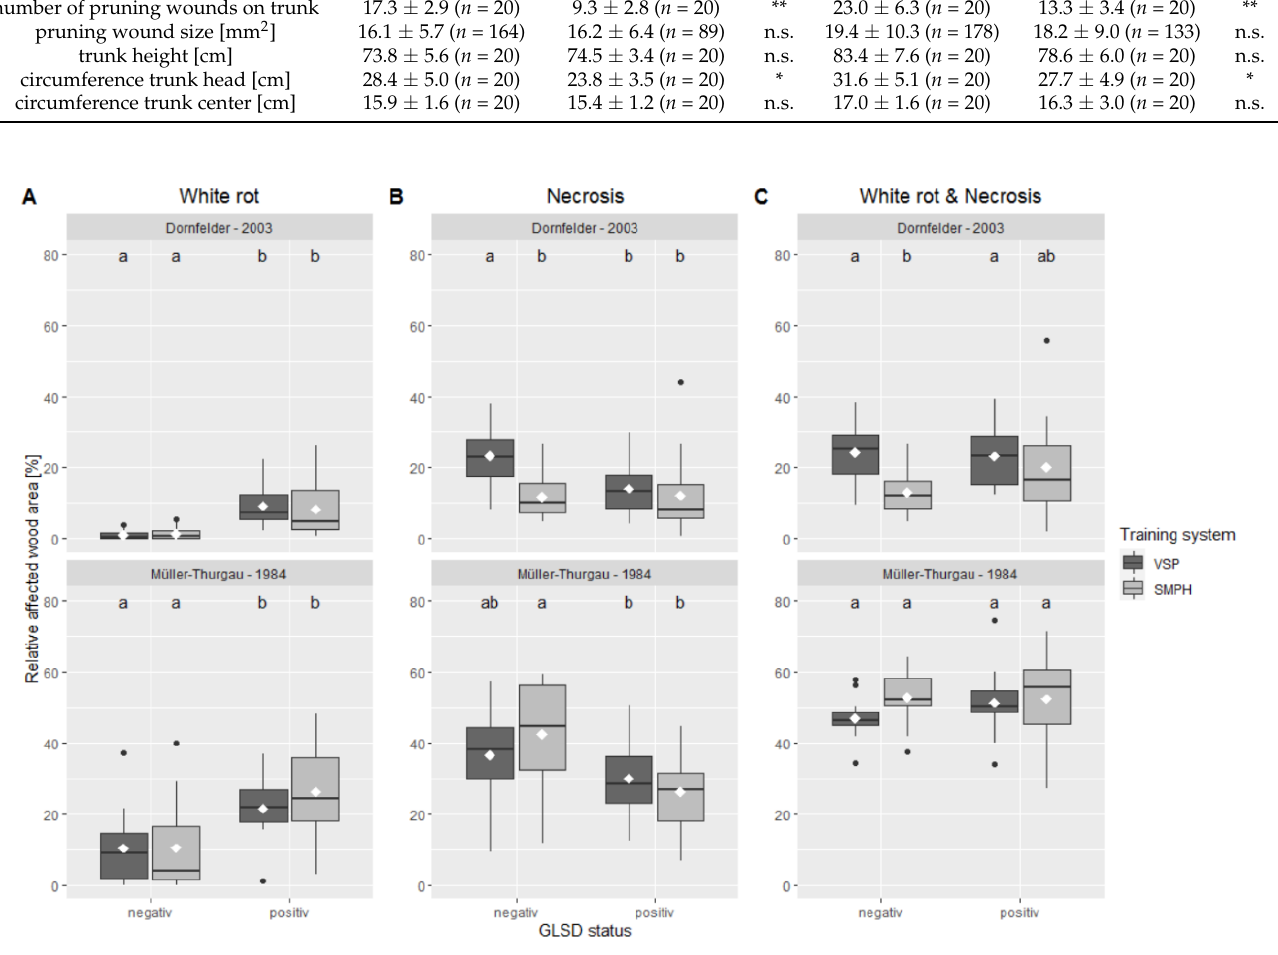
Figure 4. Inner-wood integrity by means of ( A ) white rot, ( B ) discoloration/necrosis and ( C ) both combined in terms of percentage of affected area in longitudinal sections as a function of the training system (VSP and SMPH) and esca status (‘positive’ and ‘negative’) in the two studied vineyards (‘Dornfelder’ and ‘Müller-Thurgau’). Different letters indicate significant differences according to two-way ANOVA ( p < 0.05).